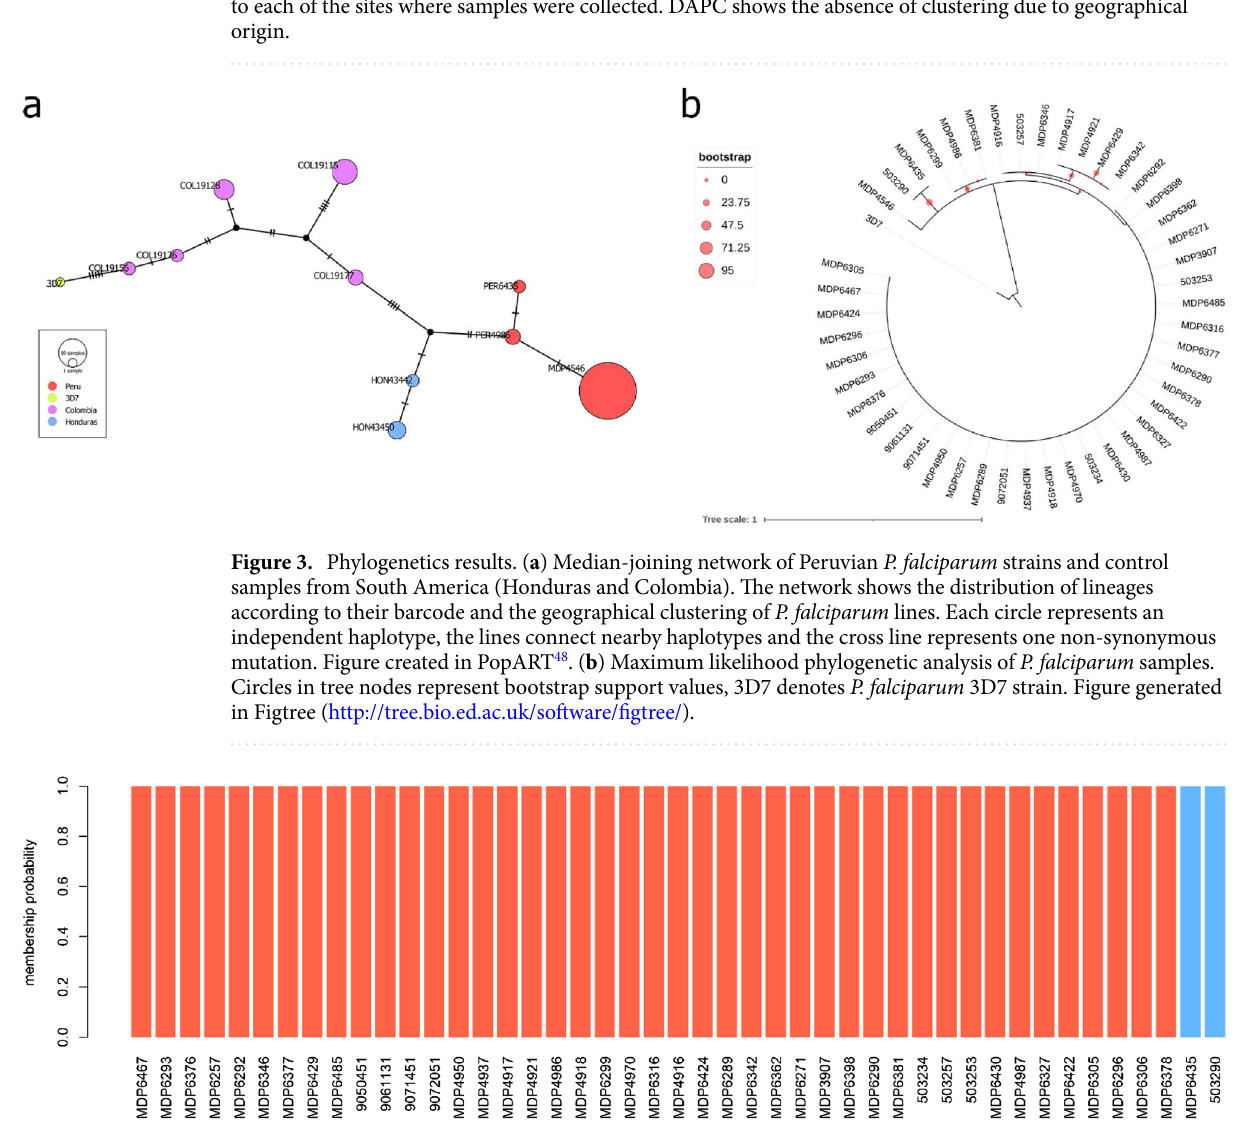
Figure 4. K-means clustering for P. falciparum samples. The y-axis denotes the membership probability of each sample to belong to a cluster whereas the color defines the two clusters that were identified for P. falciparum